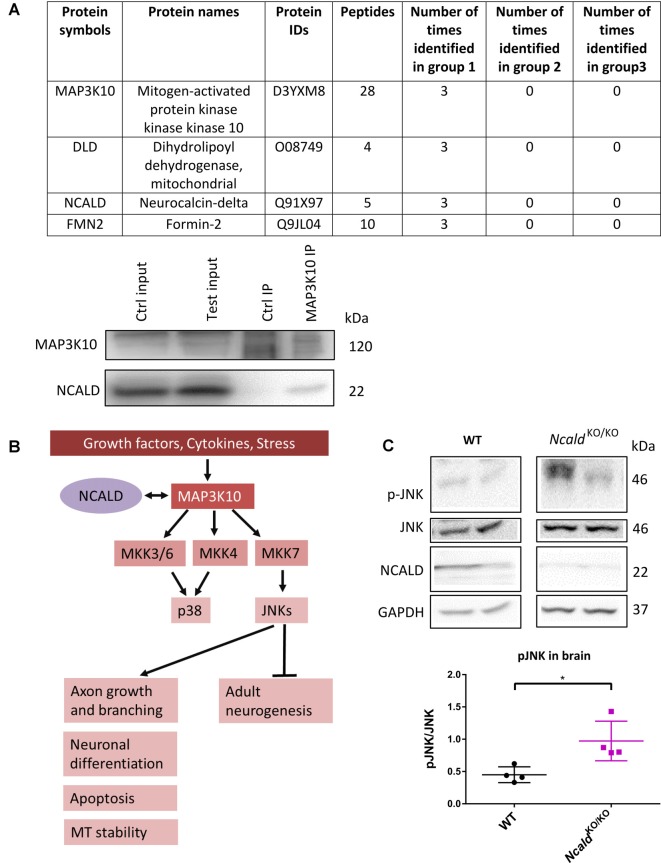
MAP3K10 interacts with NCALD and the downstream JUN N-terminal kinase (JNK) pathway is misregulated in NcaldKO/KO brains. (A) Proteins identified to be present in all WT but not in NcaldKO/KO or negative control (beads only) brain lysates at P30. NCALD was immunoprecipitated using an NCALD-specific antibody and peptides were identified by mass spectrometry. Interaction between MAP3K10 and NCALD was confirmed by co-immunoprecipitation analysis. (B) Schematic illustration of MAP3K10-dependent regulation of JNK and P38 signaling pathways (modified from Hirai et al., 1997). (C) Representative Western blots and dot plots analysis showing a significant increase in JNK signaling in 4-month-old NcaldKO/KO brain lysates compared WT controls. For quantification, pJNK levels were normalized to the total JNK levels; N = 4; *P < 0.05. Uncropped Western blots are included in Supplementary Data Sheet 8.